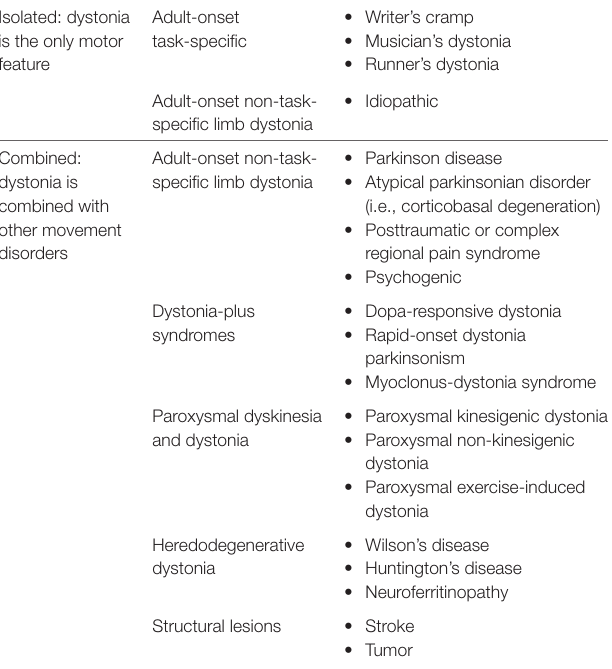
TAbLe 1 | Limb dystonia by etiology. Isolated: dystonia is the only motor